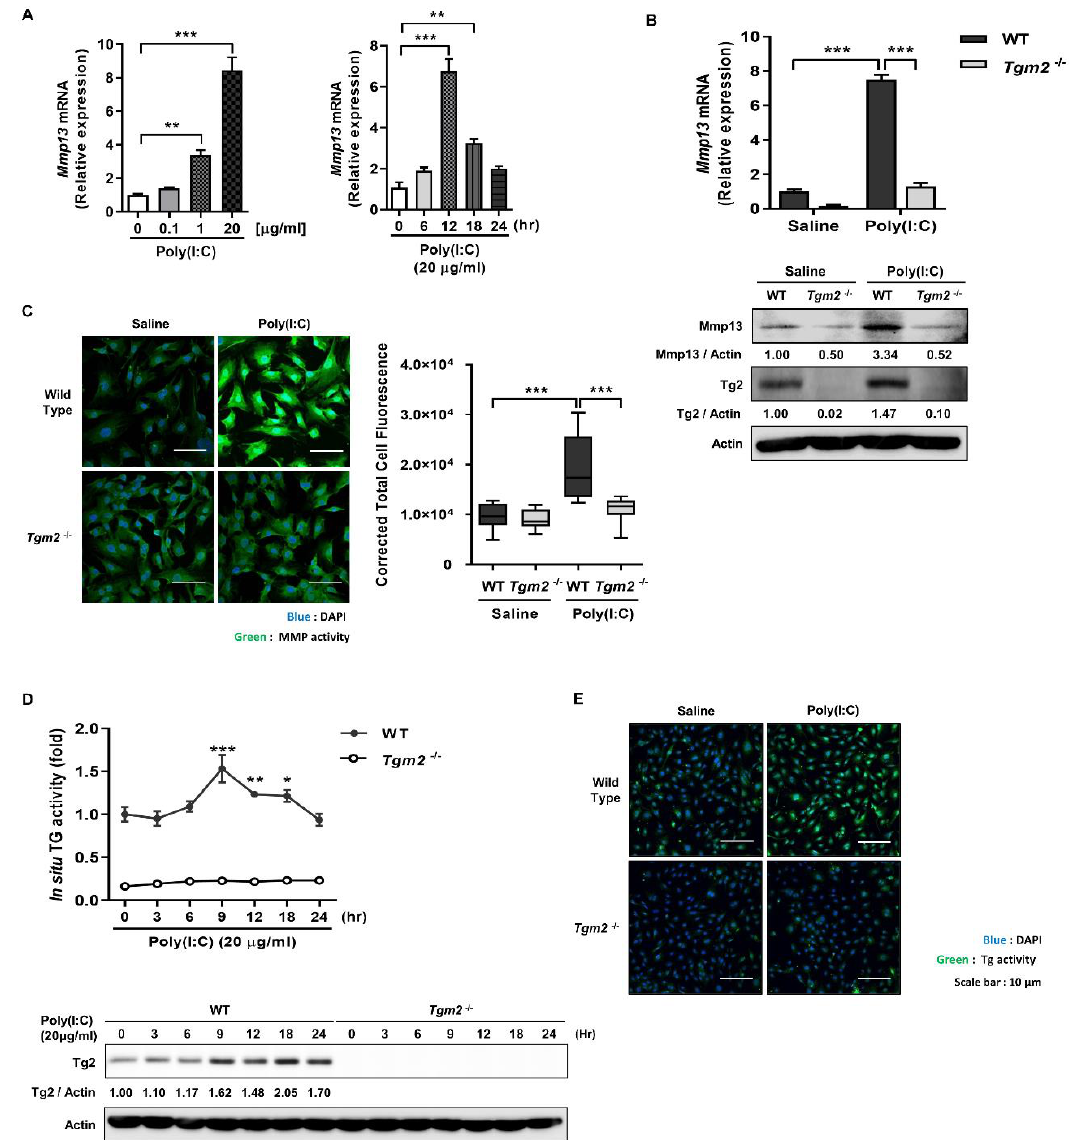
Figure 2. Tgm2 -deficient MDFs exhibit reduced Mmp-13 expression in response to poly(I:C) treatment. ( A ) MDFs were treated with various concentrations of poly(I:C), and mRNA levels of Mmp13 were measured after 12 h using qRT-PCR (left, n = 3). Mmp13 mRNA levels of MDFs treated with 20 µg/mL of poly(I:C) were monitored for 24 h (right, n = 3). ( B ) Mmp13 mRNA level (upper panel) and